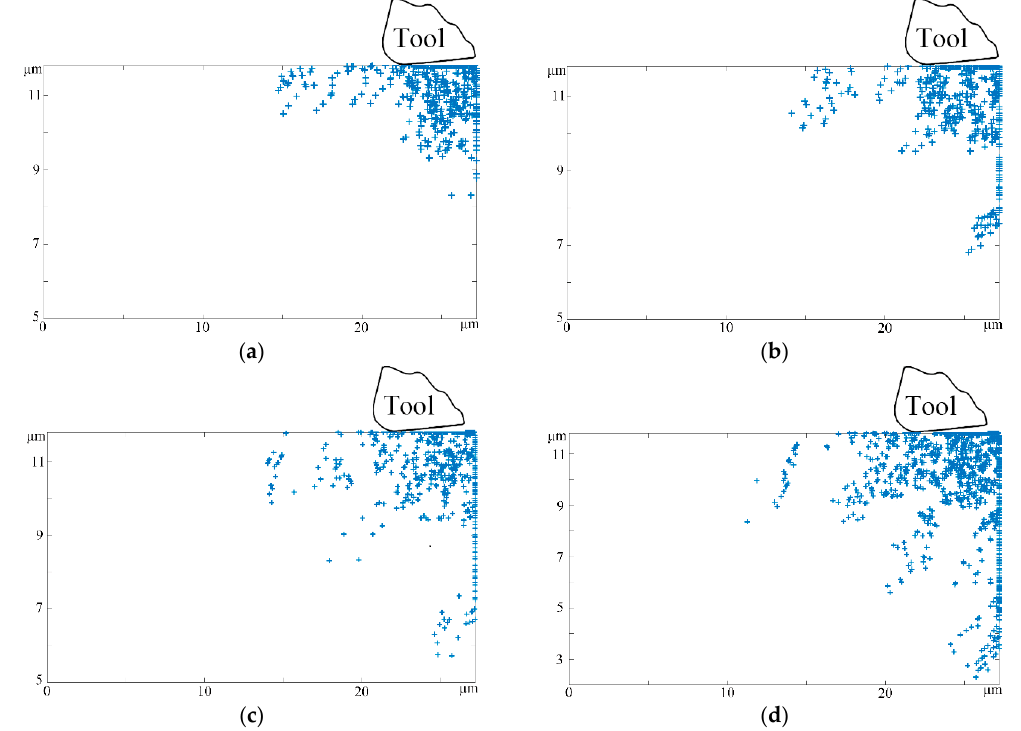
Figure 3. The subsurface defects microstructural evolution with different tool edge radii (cutting distance 5 μ m, cutting speed 10 m/s, cutting depth 1 μ m, rake angle 5°, and clearance angle 15°). ( a ) tool edge radius 0 μ m; ( b ) tool edge radius 0.25 μ m; ( c ) tool edge radius 0.5 μ m; ( d ) tool edge radius 1 μ m.